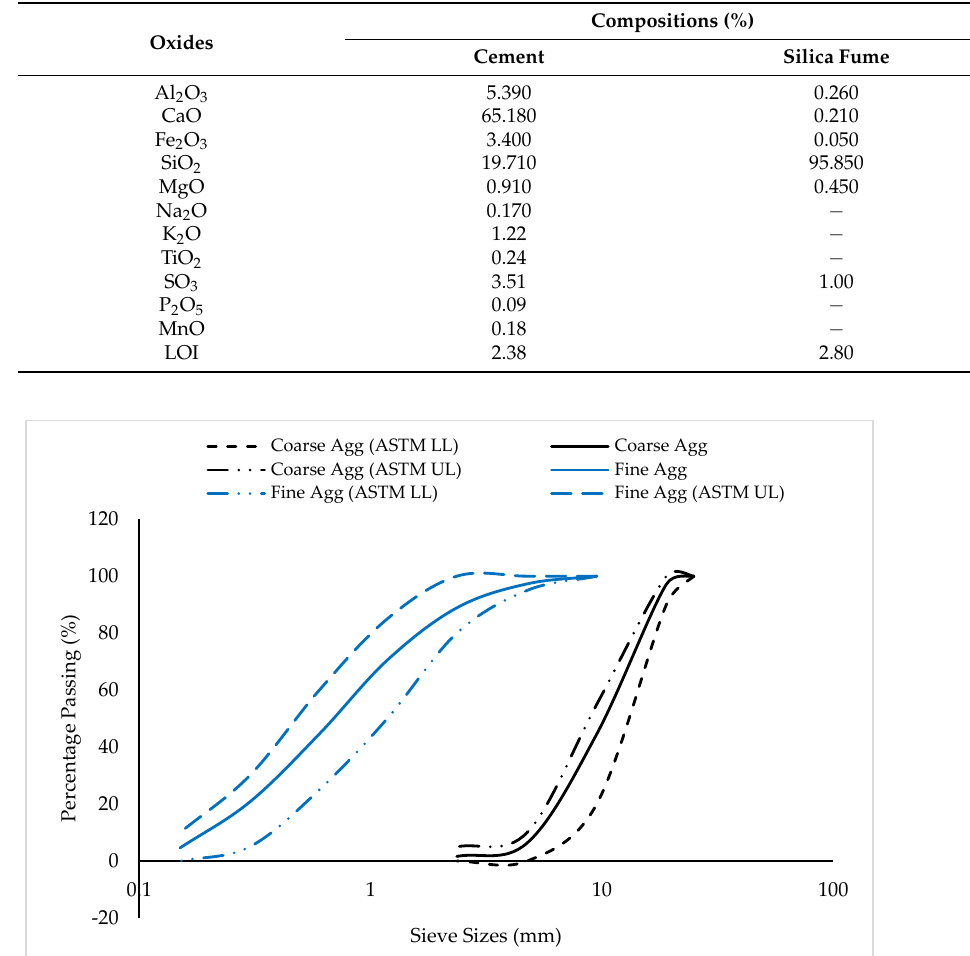
Table 1. Chemical properties of cementitious material.